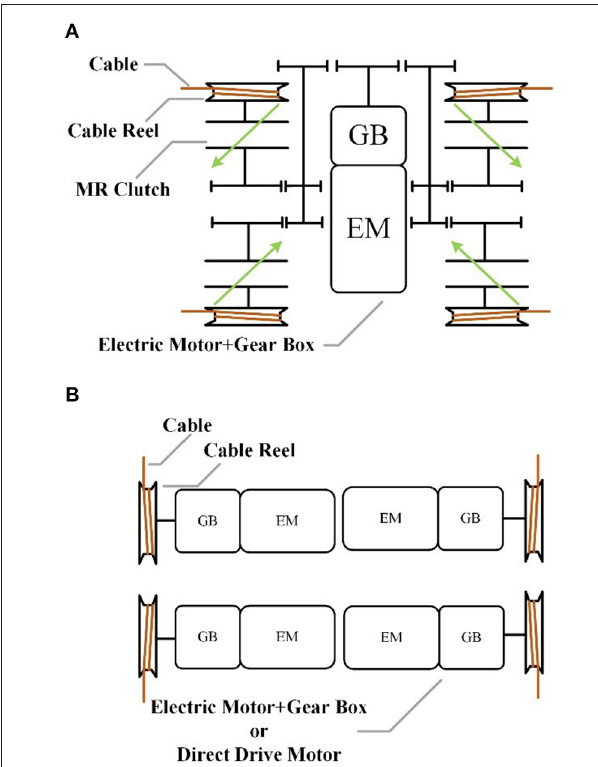
FIGURE 3 | The schematic of two different drive systems: (A) the DASA system based on MRs, (B) the conventional electric motor drive system.